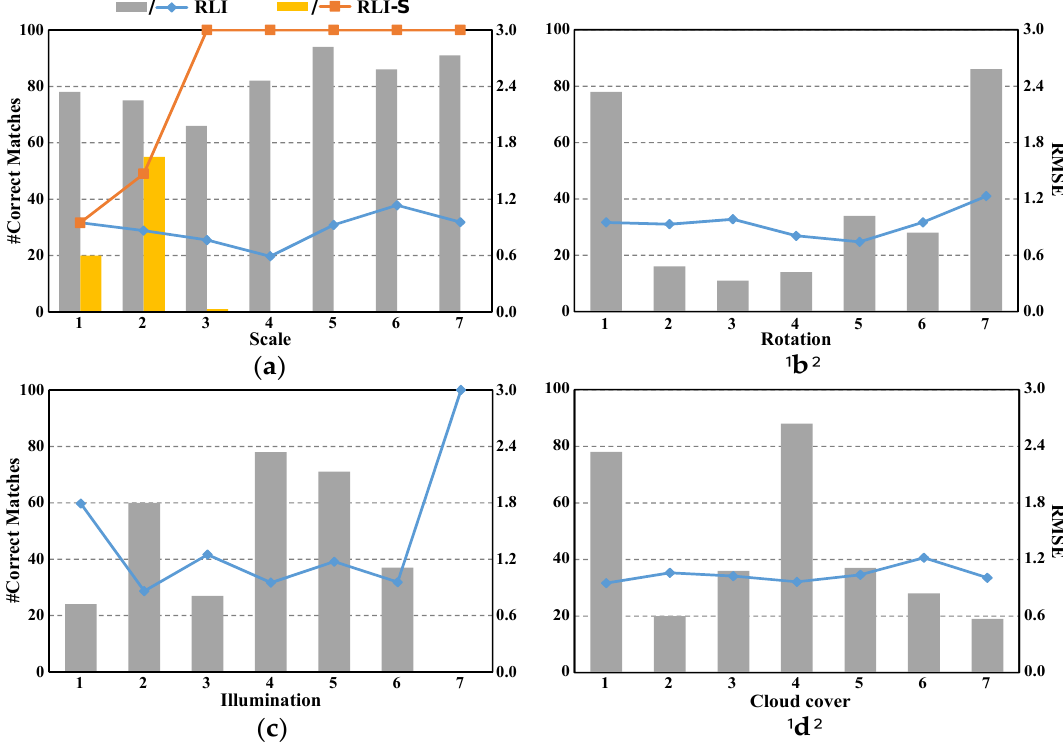
Figure 9. Performances of the proposed RLI method in terms of root-mean-square error (RMSE) and number of correct matches over synthetic images under conditions of ( a ) scale, ( b ) rotation, ( c ) illumination, and ( d ) cloud